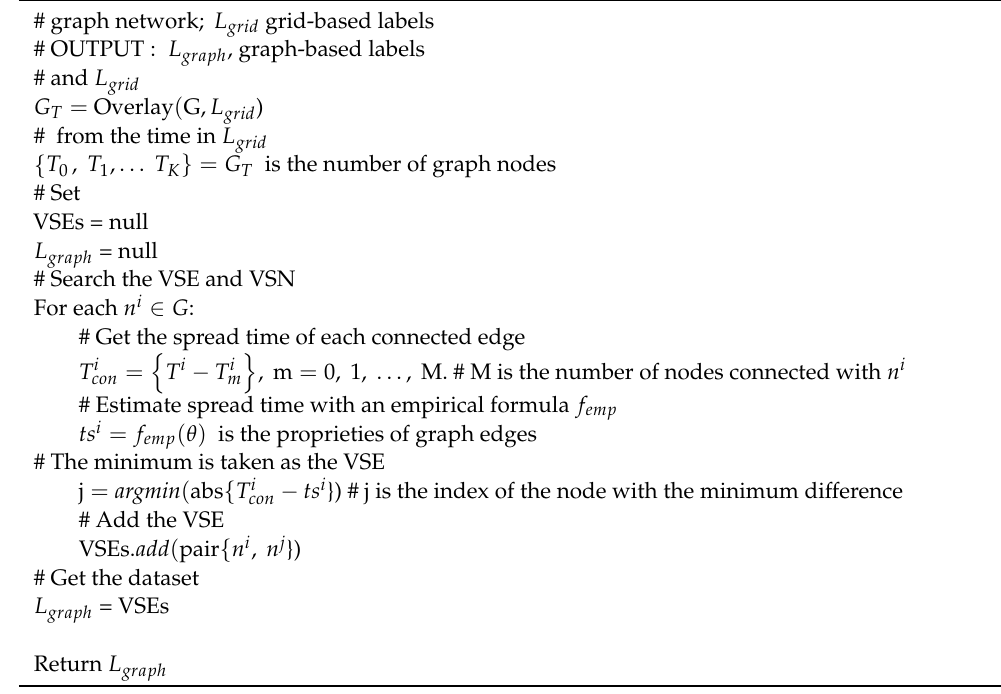
Algorithm A2 Grid-Graph matching